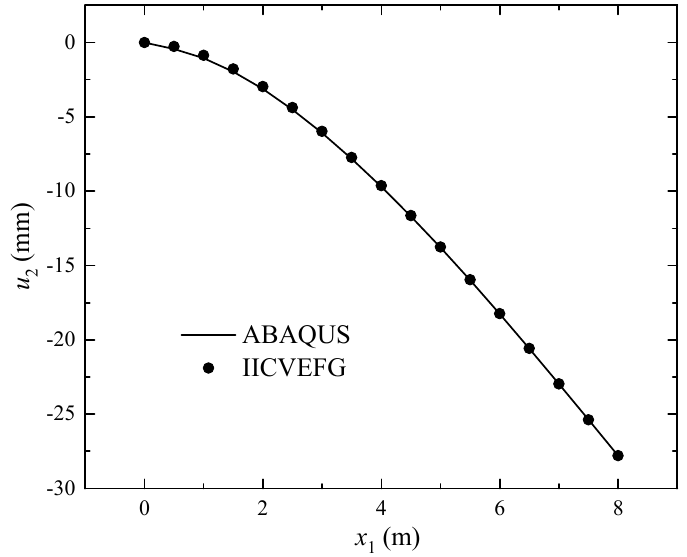
u of the nodes on the 1